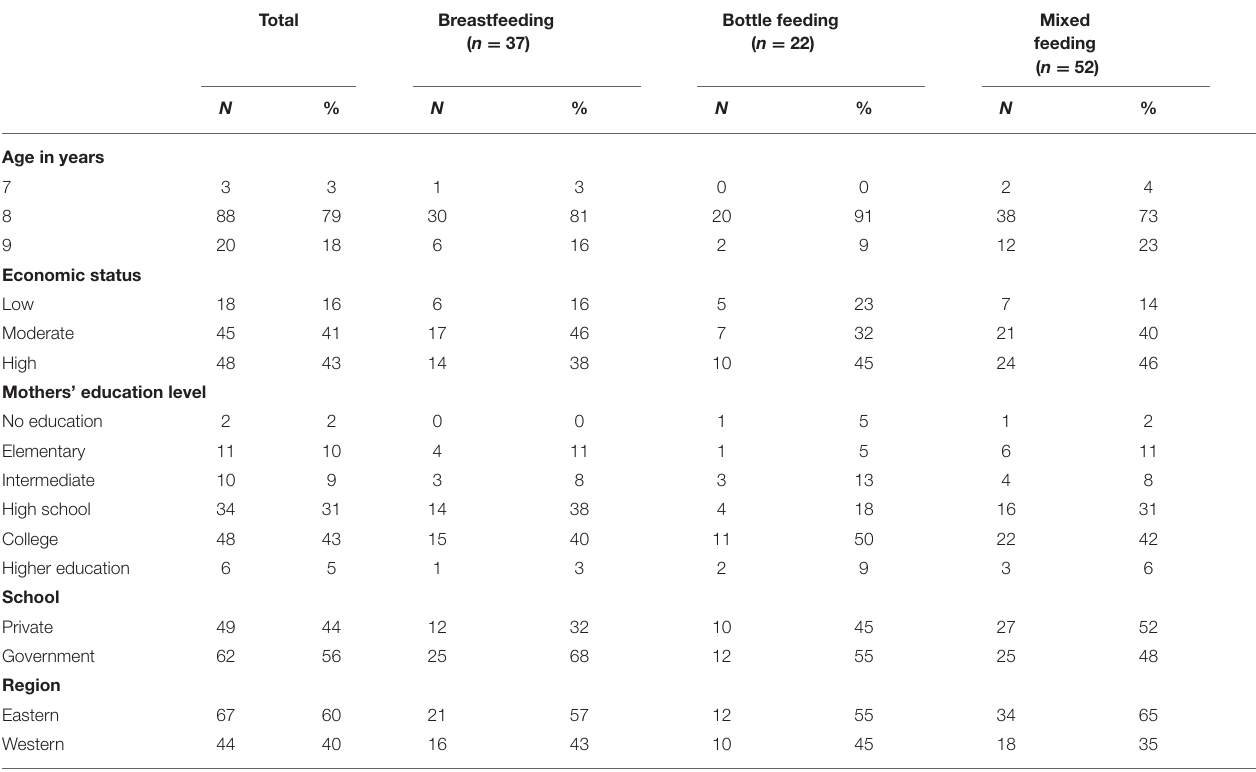
Total Breastfeeding